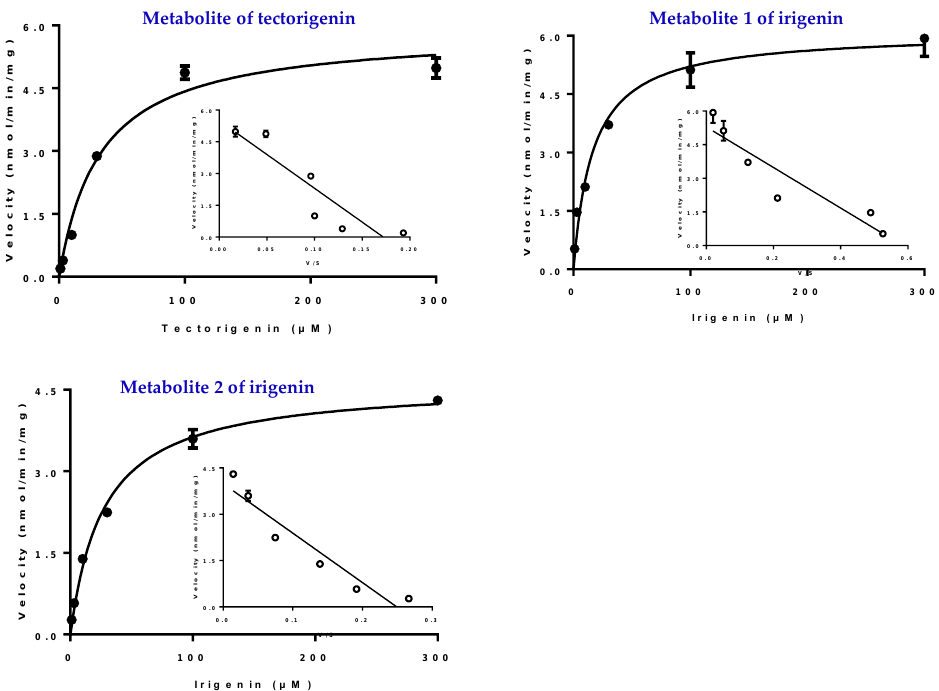
Figure 6. Kinetic profiles for formation of glucuronidation of tectorigenin and irigenin in HLMs (the filled circle). In each panel, the inset figure shows the corresponding Eadie–Hofstee plot (the hollow circle). All experiments were performed in triplicate. Data represent the mean ± SE ( n = 3). The detailed kinetics parameters of UGT1A1 and 1A9 for M, M1, and M2 are shown in Table 3 and Figure 7. The K m and V max values for tectorigenin glucuronidation with UGT1A1